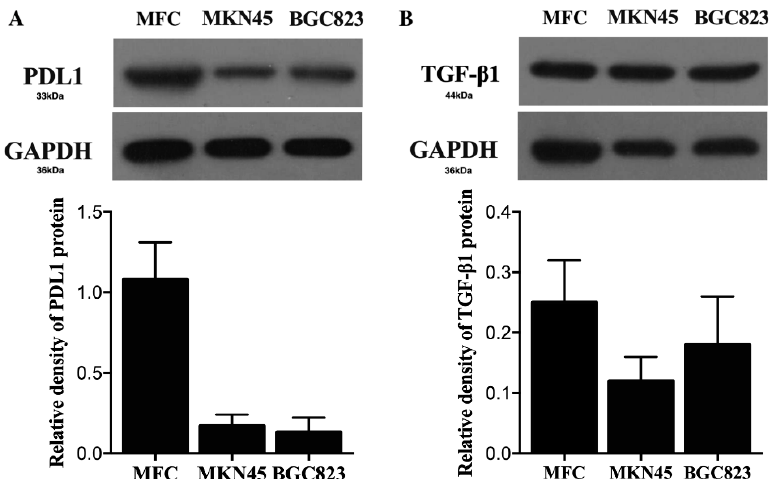
Figure 8. Detection of PDL1 and TGF- β 1 expression levels. ( A ) Western blot analysis and protein quantification of PDL1 expression in MFC, MKN45 and BGC823 cells. ( B ) Western blot analysis and protein quantification of TGF- β 1 expression in MFC, MKN45 and BGC823 cells ( α PDL1, anti- programmed cell death-Ligand 1; TGF- β 1, Transforming Growth Factor- β 1).